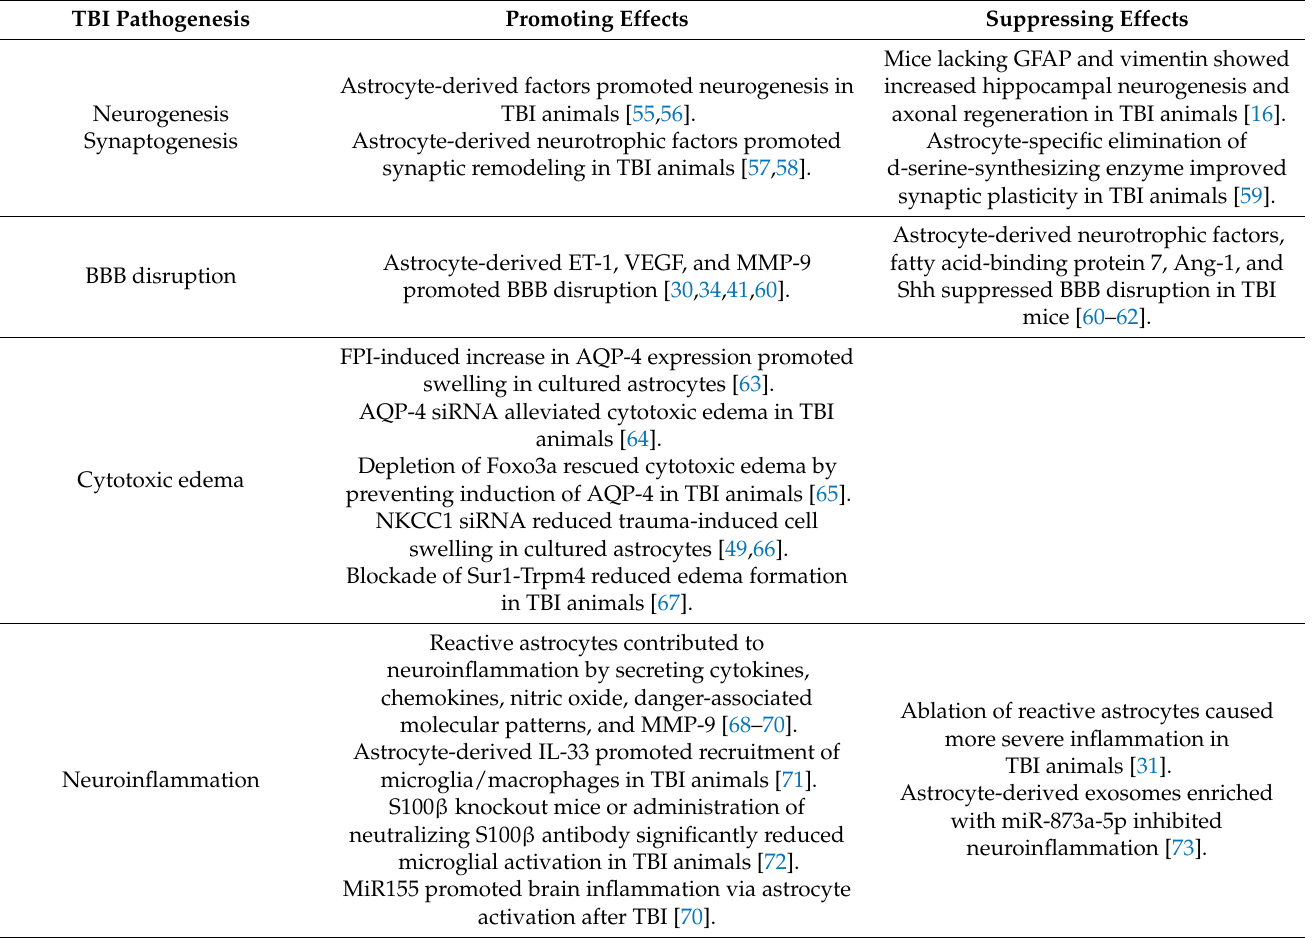
Table 2. Summary for roles of the reactive astrocytes in